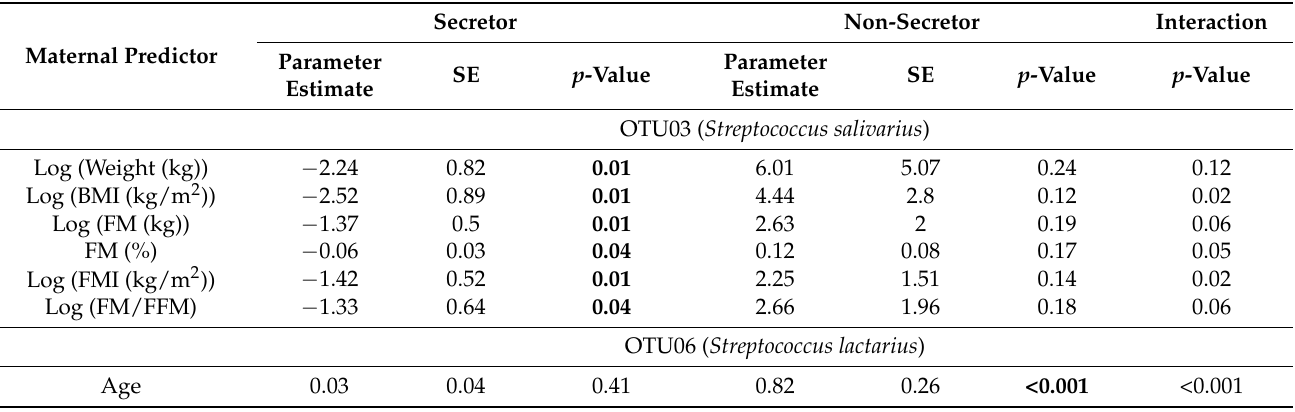
Table 2. Associations between maternal body composition and human milk bacterial OTU relative